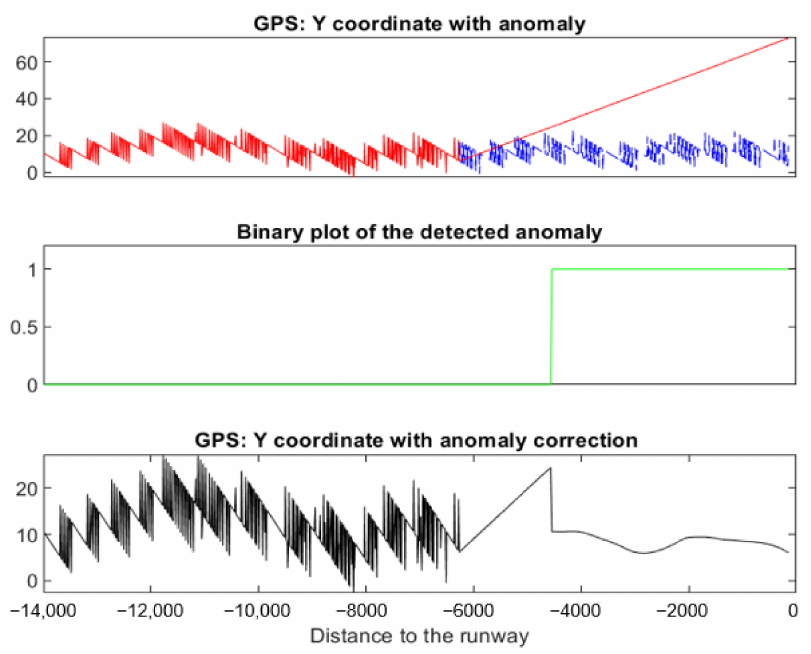
Figure 31. Drift anomaly detected and corrected on a specific landing using